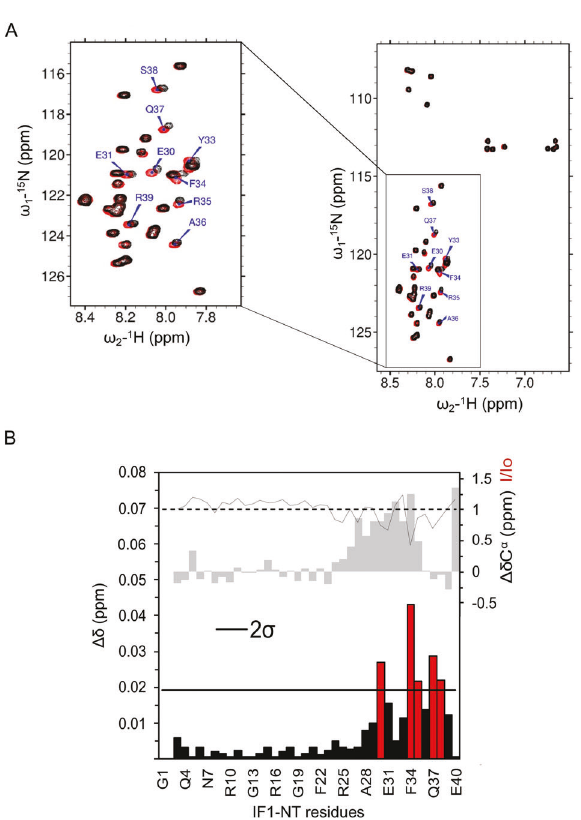
Fig. 3 IF1-NT interacts in vitro with OSCP-NT through its N-terminal region. A 1 H- 15 N SOFAST-HMQC spectrum of IF1-NT (residues G1-E40) in the absence (red) and in the presence of a 15- fold molar excess of unlabeled OSCP-NT (residues R6-G114) (black). The expanded plot shows the region of the spectrum containing the cross peaks with pronounced chemical shift perturbation, which are labeled. B Combined chemical shift perturbations (colored bars, left axis, bottom panel) derived from the experiments shown in A . Red bars indicate residues showing a deviation larger than 2 standard deviations (2 σ ) from the average. The gray line on the top of the panel represents the normalized signal intensity changes in IF1-NT upon addition of OSCP-NT (right axis, top panel, I / I 0 ). I and I 0 are the intensities of 1 H- 15 N cross peaks in the presence or absence of 15- fold molar excess OSCP-NT, respectively. The gray bars on the top of the panel indicate the 13 C α secondary chemical shifts (right top axis, in ppm) calculated using the Poulsen library for disordered proteins [72]. Positive secondary chemical shift values are an indication of helical The IF1 mutant Y33R binds to OSCP subunit, but not to the F1 sector, causing inhibition of permeability transition and promoting colony formation In order to clarify which of the two IF1 binding sites might be involved in the desensitization of the PTP between (1) the